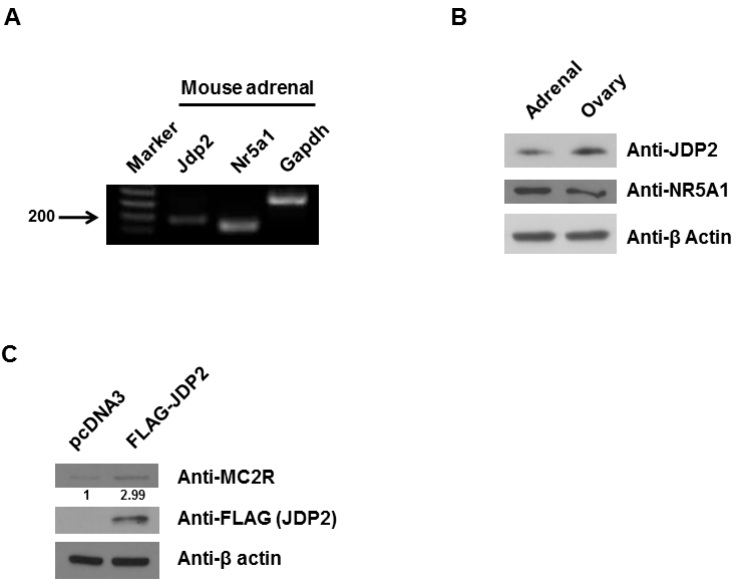
Figure 1. JDP2 is expressed in adrenal glands and increases melanocortin 2 receptor (MC2R) level. ( A ) RT-PCR analysis of Jdp2 and Nr5a1 expression from mouse adrenal glands. Total RNA was extracted and reverse transcribed to cDNA followed by PCR analysis and fractionation using agarose gel electrophoresis. The PCR product of Jdp2 (189-bp) and the PCR product of Nr5a1 (147-bp) are present in the adrenal glands. The PCR product of Glyceraldehyde-3-phosphate dehydrogenase ( Gapdh ) served as a control to indicate the presence of cDNA in each sample; ( B ) Western blot analysis of JDP2 and NR5A1 expression from mouse adrenal glands and ovaries. The expression levels of JDP2 and NR5A1 in adrenals and ovaries were determined using anti-JDP2 and anti-NR5A1 immunoblotting, respectively. The β -Actin levels were also determined for equal loading; ( C ) Y1 cells were transfected without or with FLAG- Jdp2 expression plasmid and cell lysates were immunoblotted with anti-MC2R. The cells lysates were probed with a FLAG antibody (for JDP2 level) and a β -Actin antibody for equal loading, respectively. The experiments were performed three times.